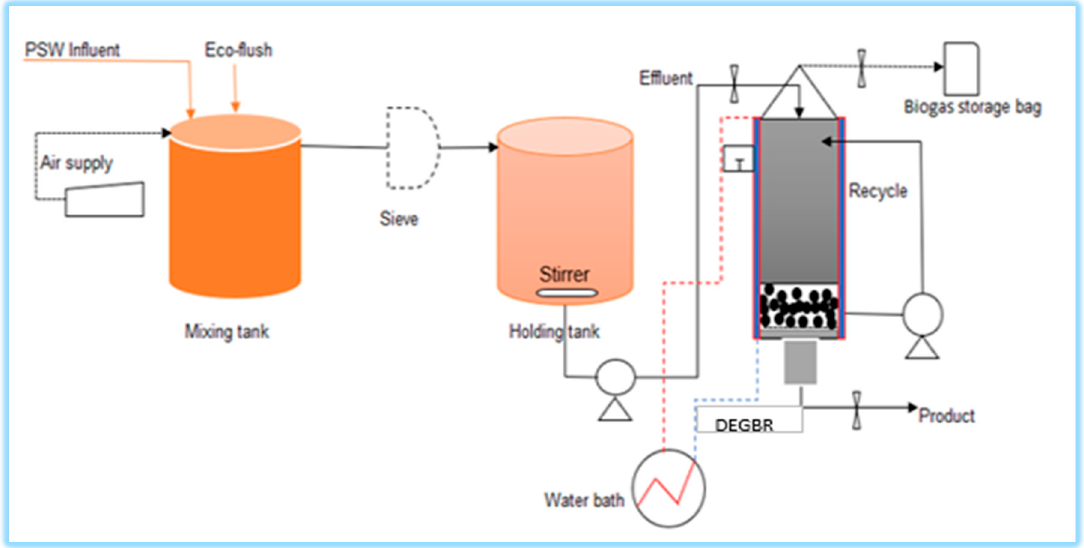
Figure 2. Schematic illustration of the modified DEGBR.